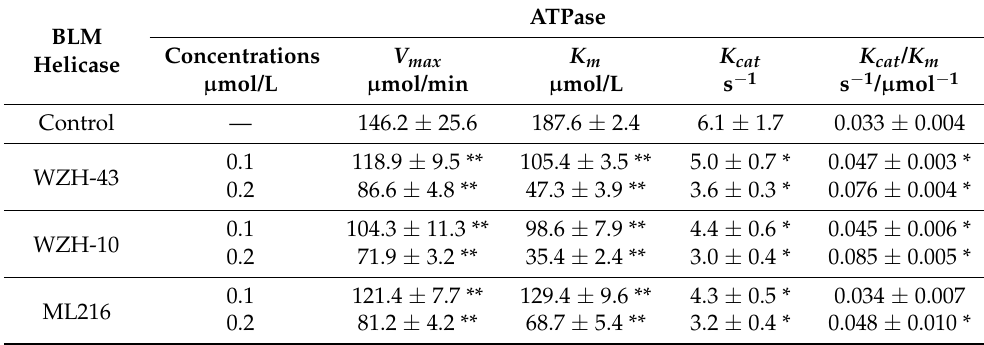
Table 1. Effects of the two prenylated chalcones on the ATPase activity of BLM helicase.